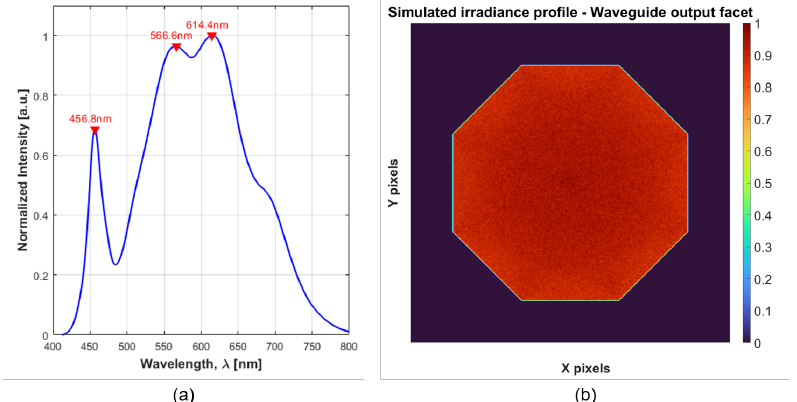
Figure 3. LED emission profiles. ( a ) Measured spectrum of the LED lamp driven at I = 1.5 A, which covers most of the visible wavelengths, thus overlapping with the LCTF transmission range. ( b ) Normalized irradiance at the output facet of the octagonal tapered hollow waveguide as simulated in ZEMAX (5 × 10 7 analysis rays, 1000 × 1000 pixels detector with 38 mm × 38 mm spatial dimensions, at 0 mm from taper output, smoothing = 2). The Lambertian LED profile was mixed through multiple internal reflections, generating a uniform irradiance pattern at the output facet.